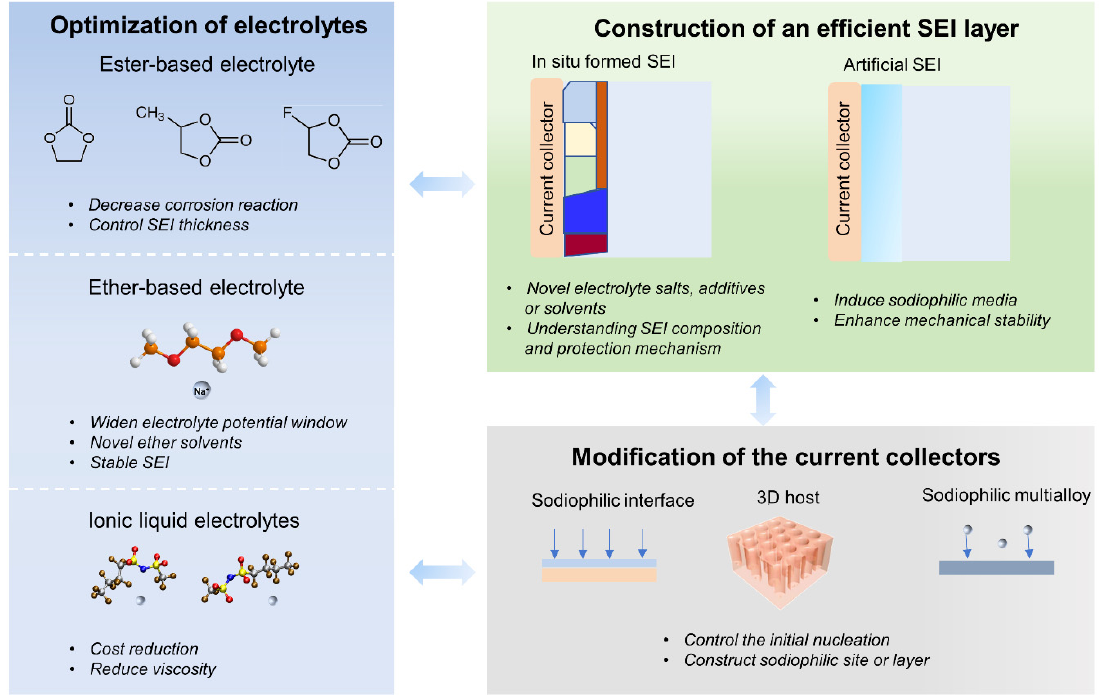
Figure 9. Summary of the current strategies concerning electrolyte chemistry, SEI, and current collectors.